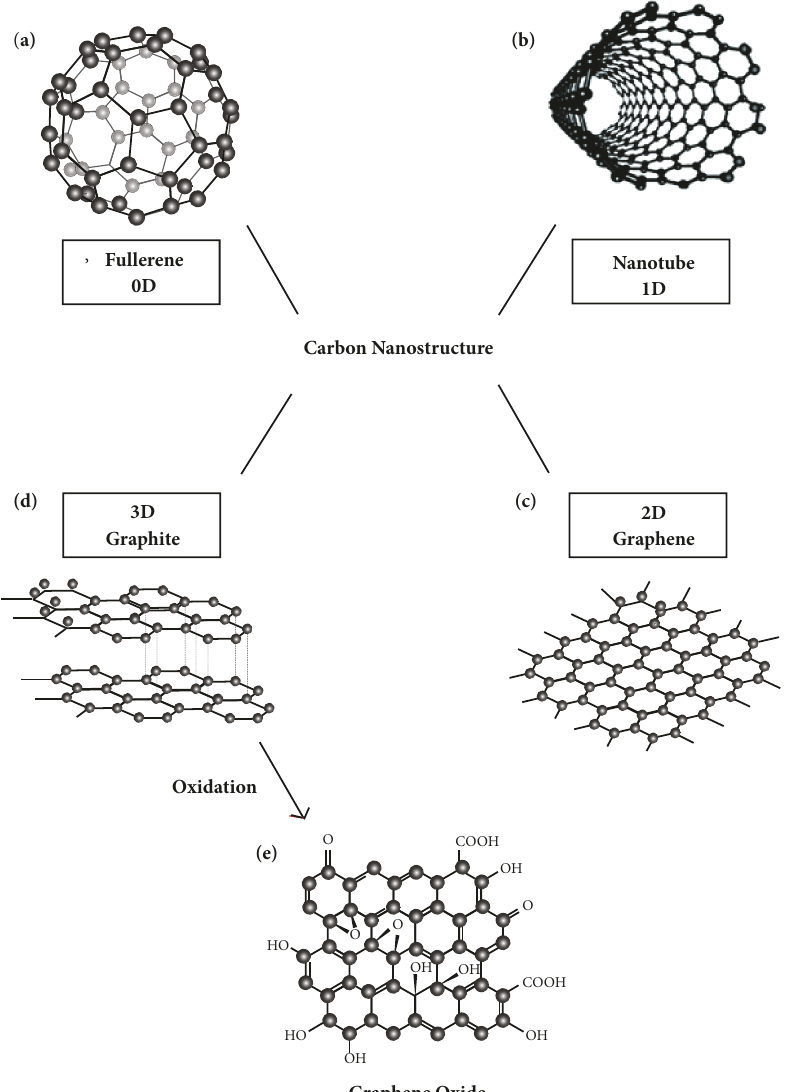
Figure 1: Different allotropes of carbon nanostructure: (a) 0D Fullerenes; (b) 1D Carbon Nanotubes; (c) 2D Graphene; (d) 3D Graphite. (e) Graphene Oxide can be synthesized through oxidation of graphite, with common method called Hummers